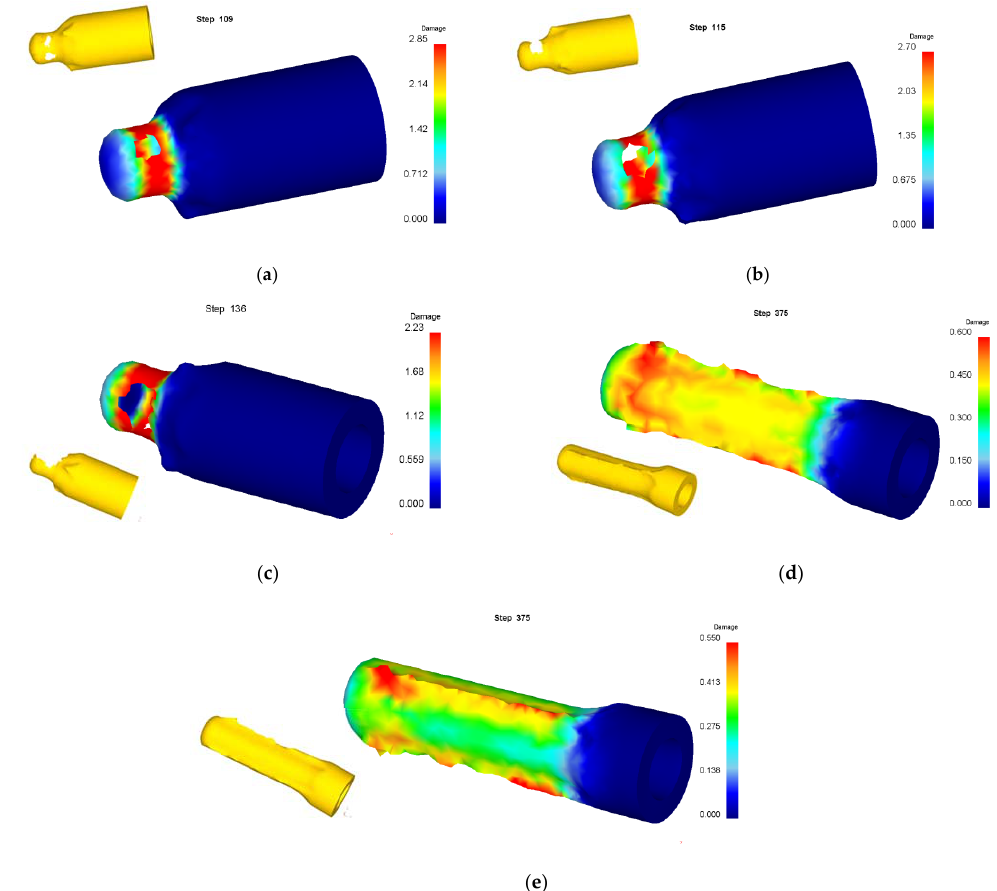
Figure 11. Damage value distribution of different friction coefficients between punch and billet. ( a ) 0.01; ( b ) 0.1; ( c ) 0.3; ( d ) 0.5; ( e ) 0.7.